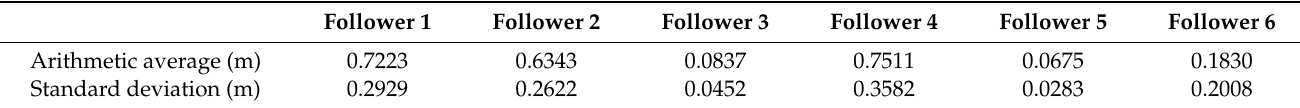
Table 5. The average distance and standard deviation between the follower and leader routes at a speed of 2.2